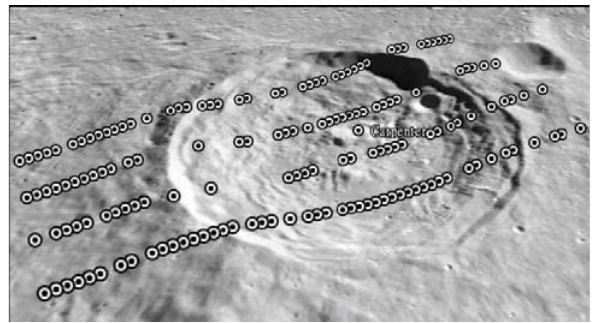
Figure 1: Scene graph of the study area